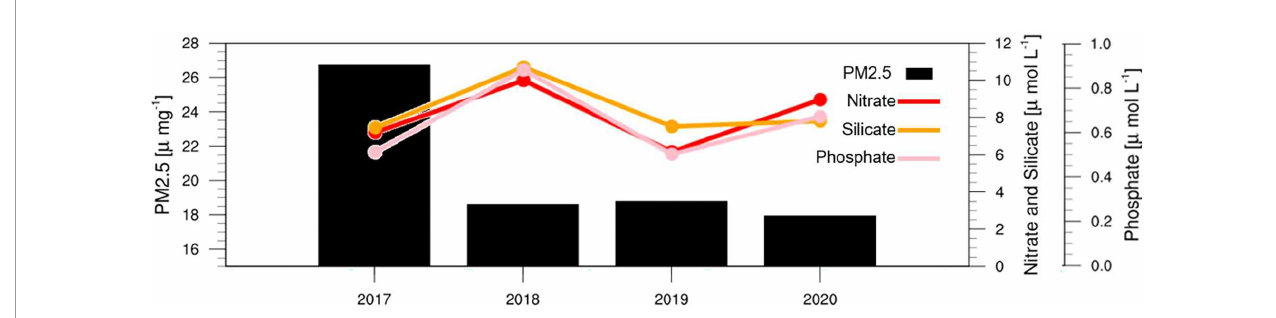
FIGURE 7 | Time series of the averaged March – April PM2.5 concentrations (bars) from the S-ORS and the mean concentration of major nutrients at a subsurface level of 20 m during February between 2017 and 2020 obtained from the 307 line of the Korea Oceanographic Data Center: nitrate (nitrite and nitrate nitrogen, red line), silicate silicon (orange), and phosphate phosphorus (pink).